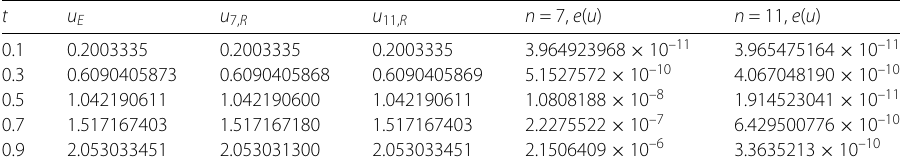
Table 5 Numerical result of Example